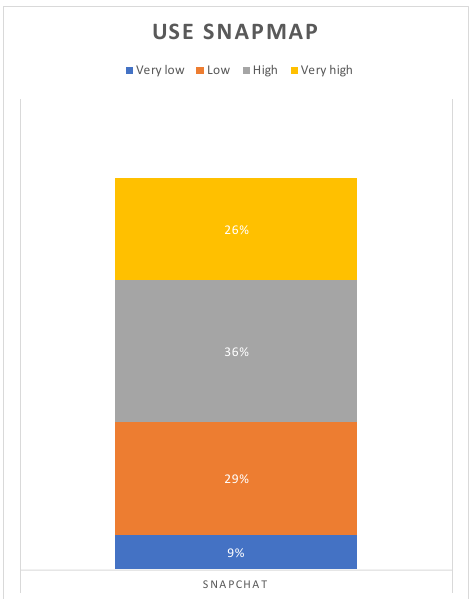
Figure 7. Shows how people perceive the risk of using Snapmap.